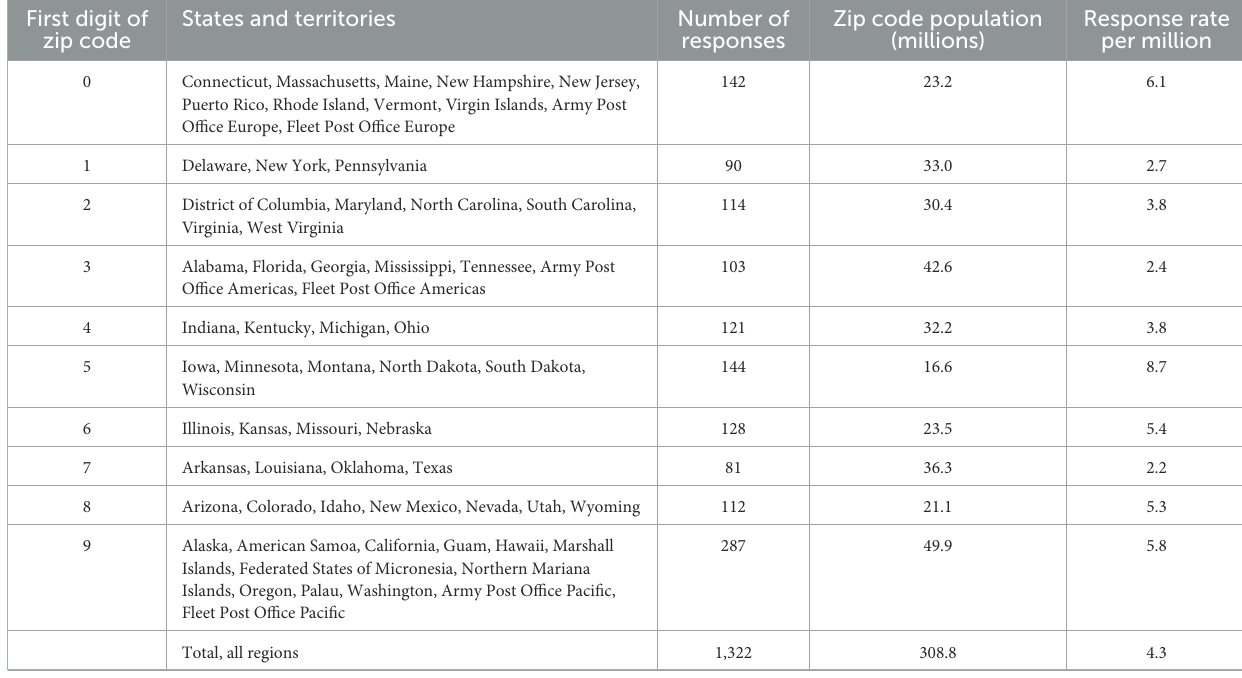
TABLE 1 Respondent numbers from regions of the US as defined by first digit of zip code for each respondent’s primary residence.